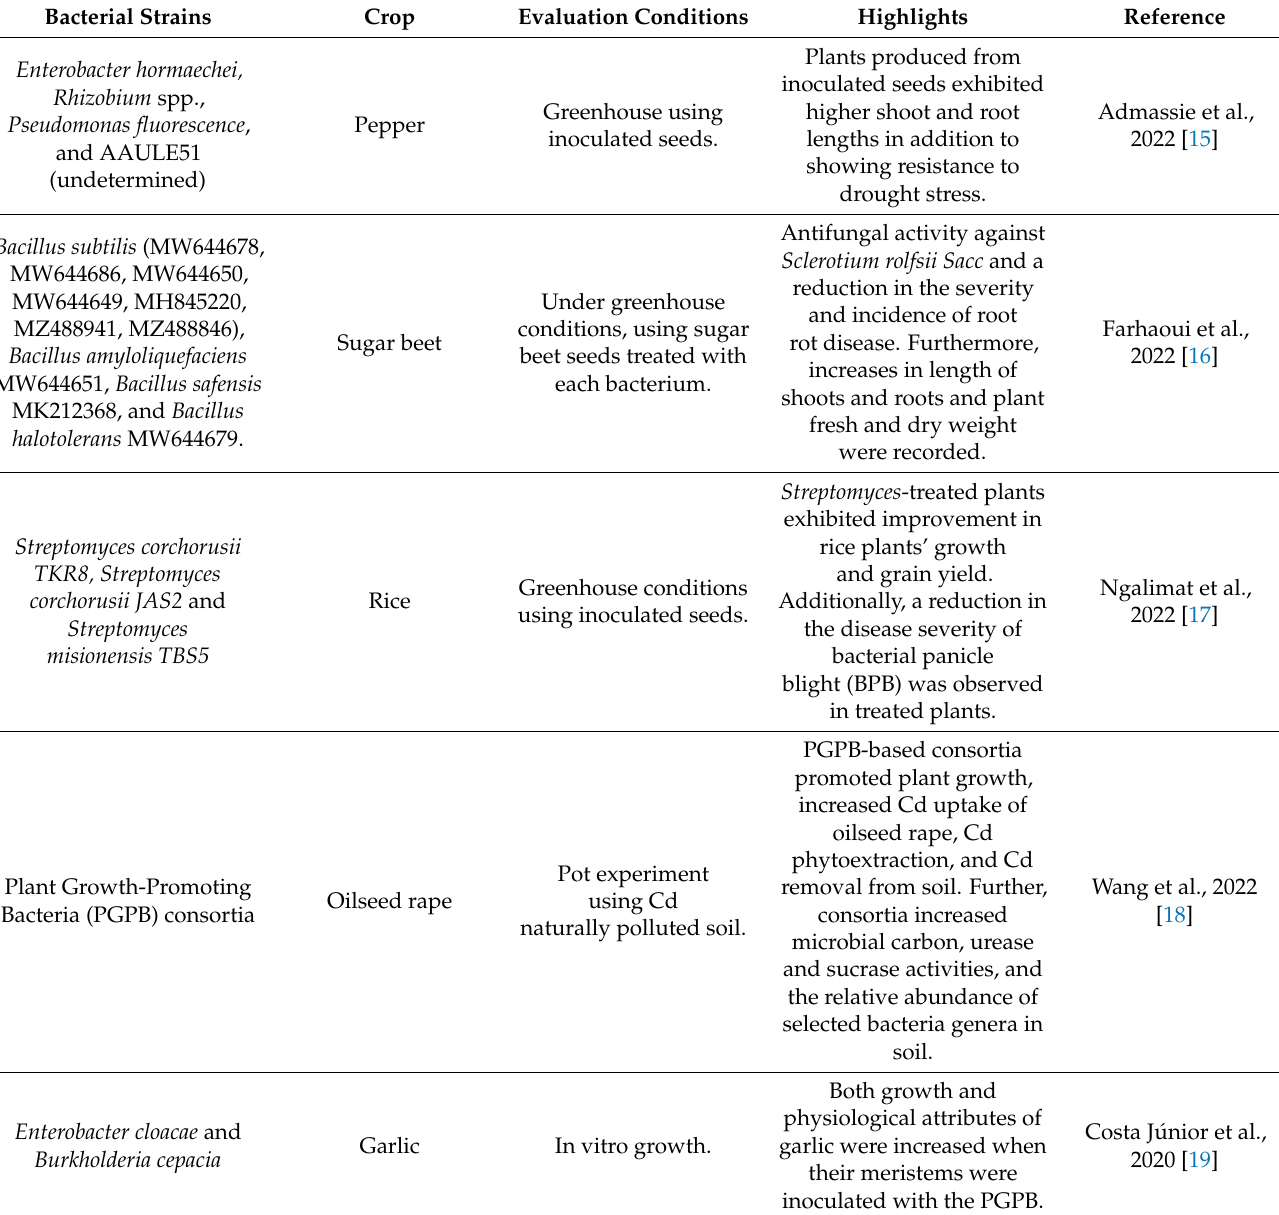
Table 1. Microorganisms with different beneficial effects in different